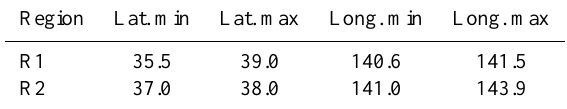
Table 3. Regions used in the experiments to analyze the chlorophyll increases. Region